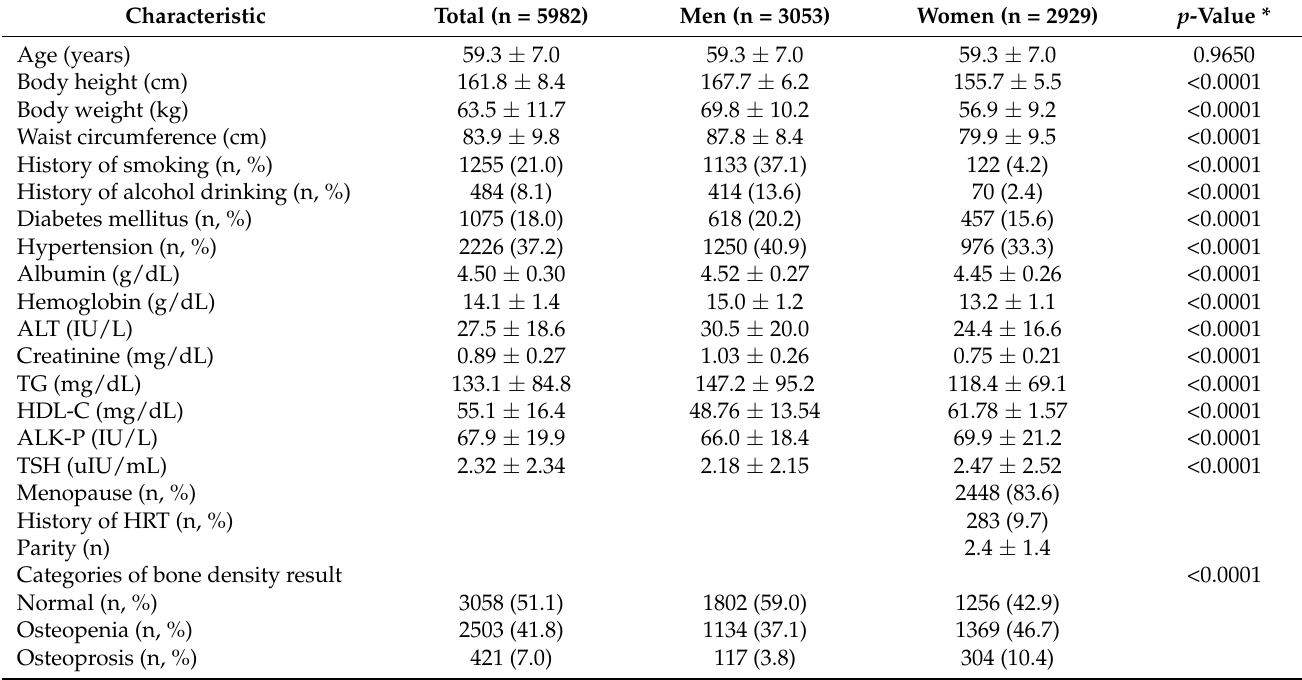
Table 2. Baseline characteristics of the study